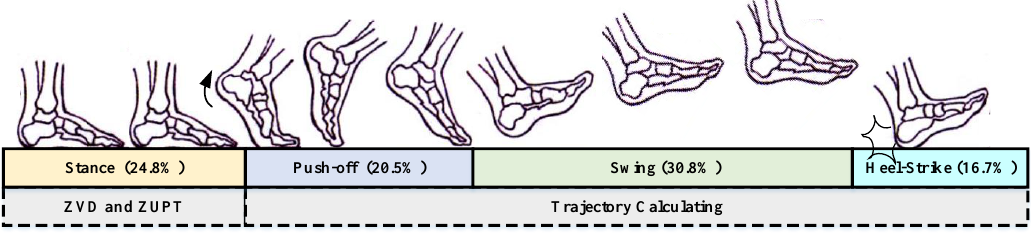
Figure 1 . Four phases of a gait cycle. ZVD: zero-velocity detector; ZUPT: zero-velocity update.